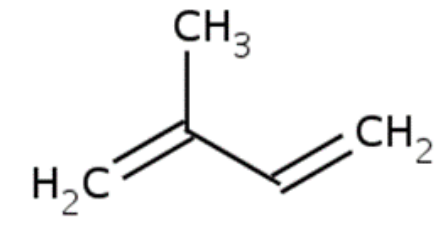
Figure. 1: Isoprene structure